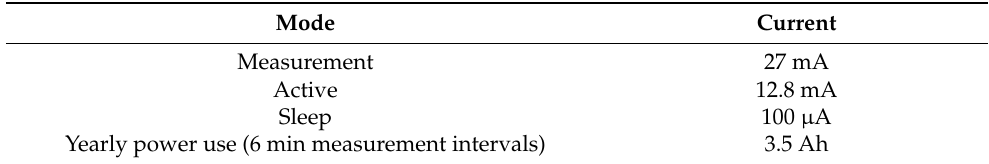
Table 1. Results of lab power usage testing. Measured current consumption for velocity sensor in various power modes.